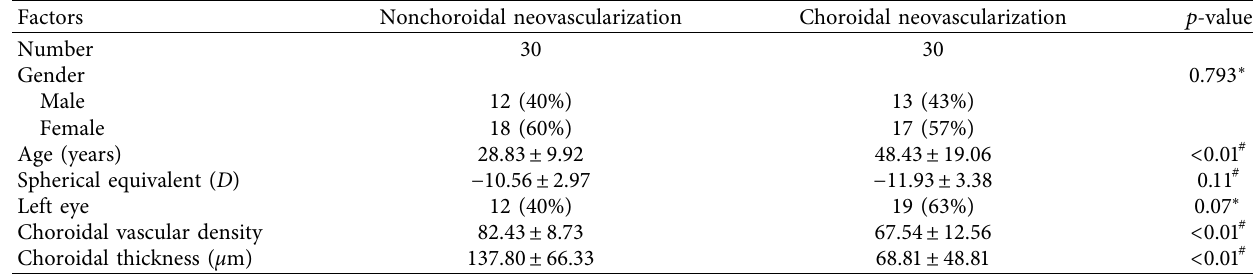
Table 1: Comparison of clinical characteristics between the included high myopia eyes with or without choroidal neovascularization. Factors